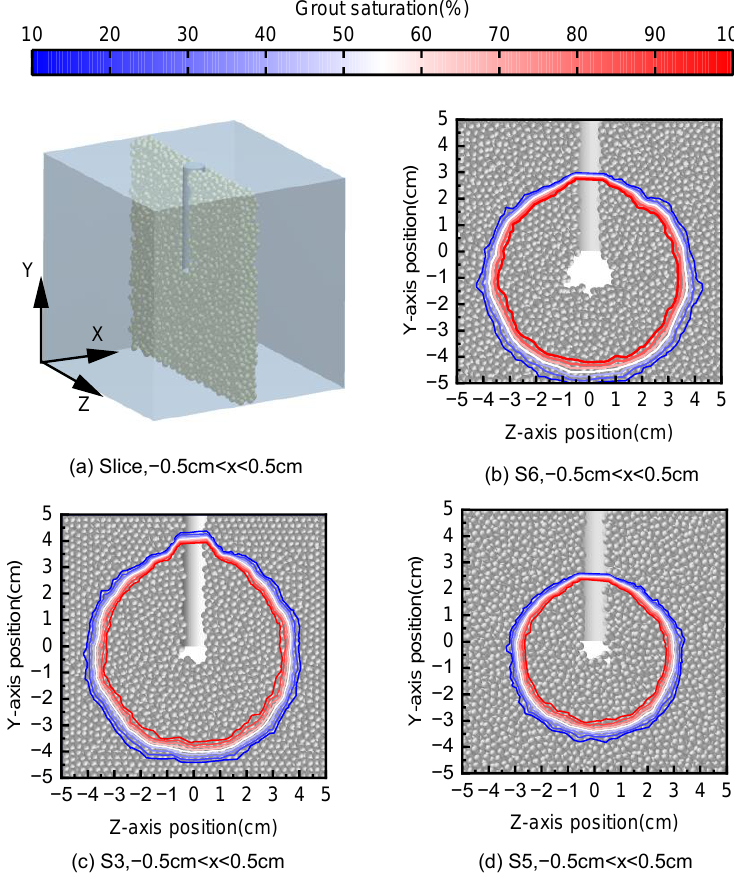
Figure 7. Grout diffusion patterns.